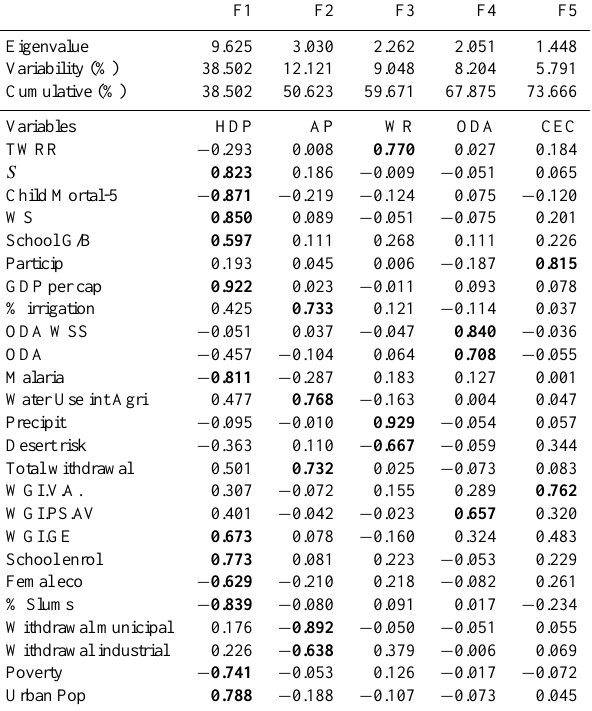
Table 3. Rotated PCA factors matrix after varimax rotation and kaiser normalization. The five components explain 73% of the vari- ability. In bold, the highest factor